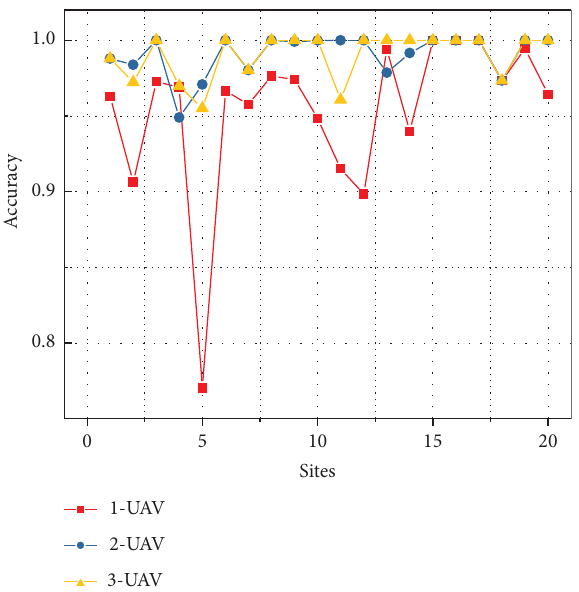
Figure 6: Heuristic solution